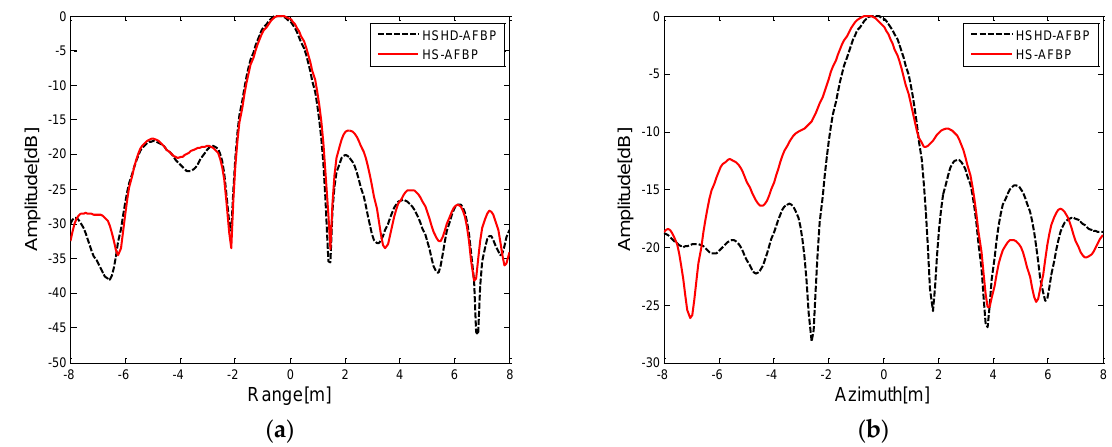
Figure 13. Range and azimuth profile comparison of HSHD-AFBP and HS-AFBP; ( a ) range profiles, ( b ) azimuth profiles.